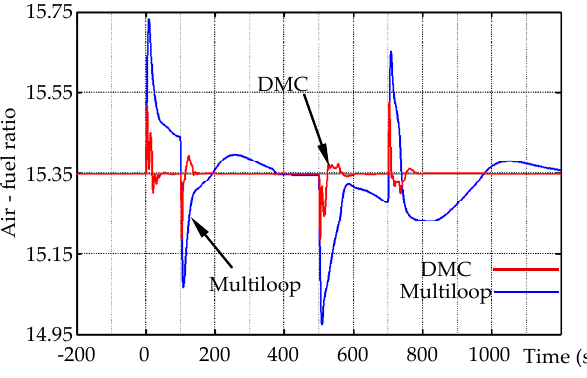
Figure 10. Comparison of AFR in 600-MW plant. Table 3. Squared error sum comparison of AFR in 600 MW